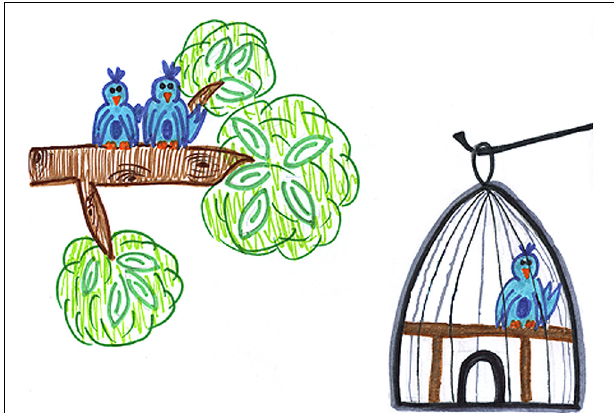
FIGURE 1 | Sample true-response stimulus material for a logical quantifier (“There are some birds in the tree”), a precise quantifier (“There are two birds in the tree”), cardinal quantifier (“There is at least one bird in the tree”), and a majority quantifier (“More than half of the birds are in the